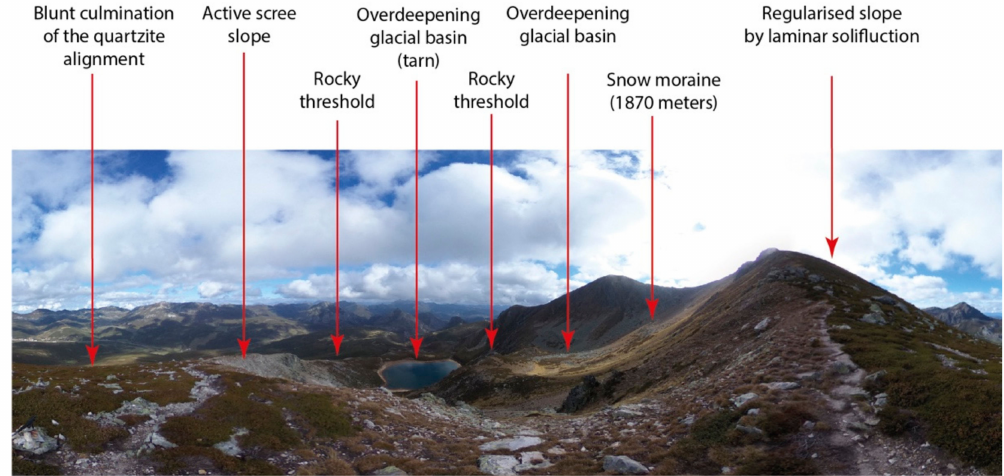
Figure 19. 360 ◦ photograph from the ninth POI. Glacial cirque with a stepped profile, bounded by the Ausente Peak and Peña de Requejines. Photograph by the authors. Focus with camera on Figure through Onirix site or use the link